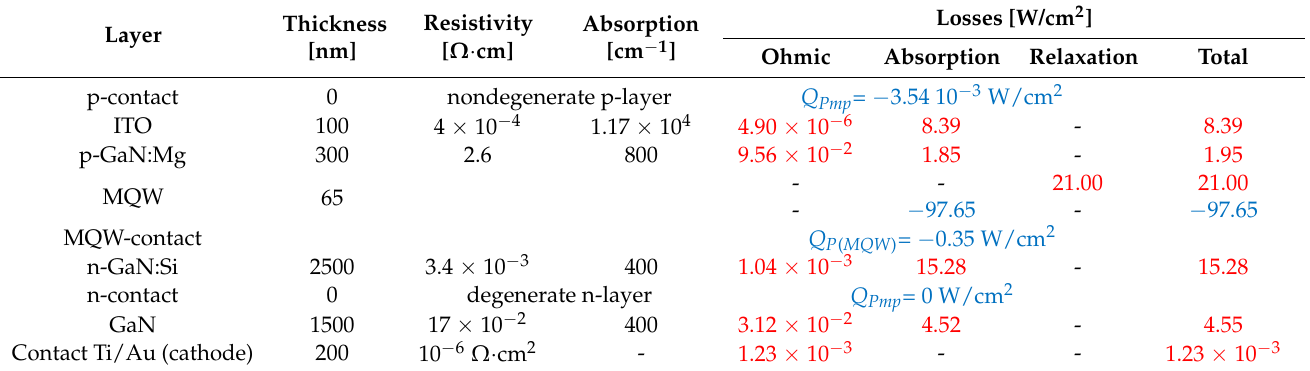
Table 2. Evaluation of energy exchange at contacts and in processes of radiative recombination, photon absorption, and ohmic losses that take place in particular layers of the considered GaN LED